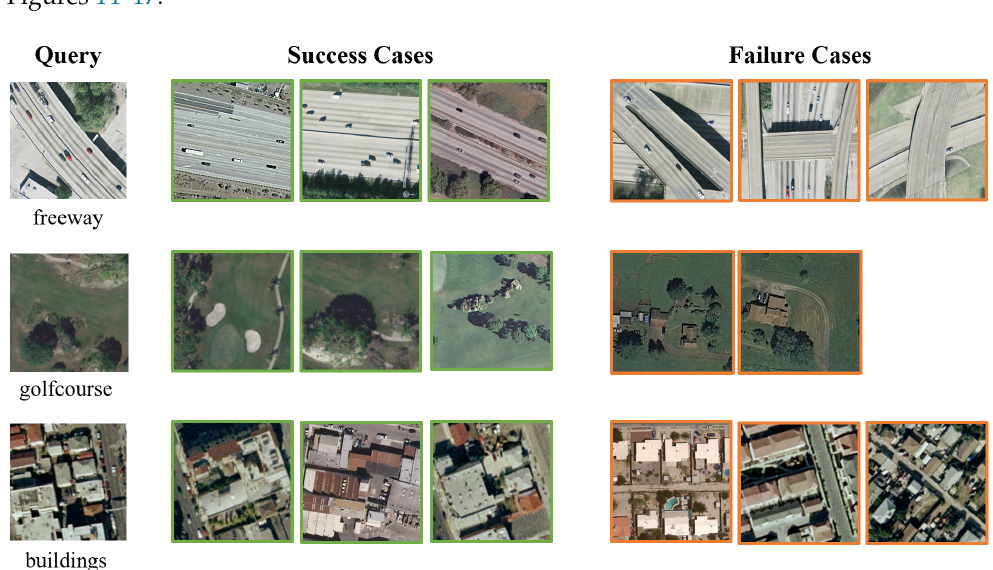
Figure 14. Examples of UCMD retrieval results. Column 1 is the query sample, columns 2–4 are the success cases of our method, and columns 5–7 are the failure